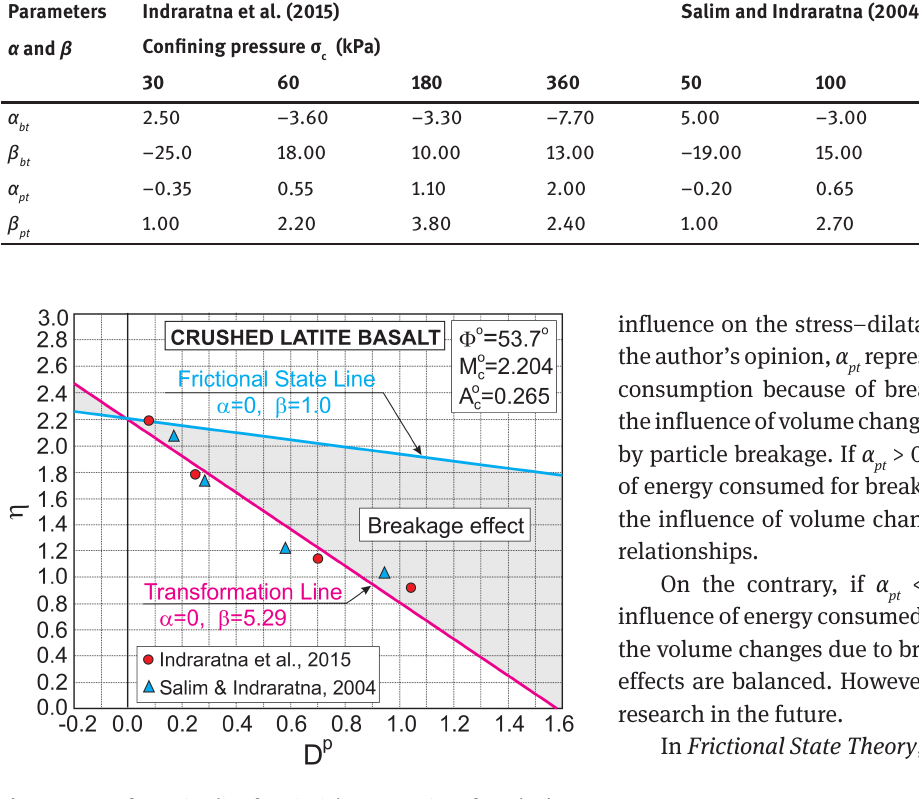
Figure 5: Transformation line for triaxial compression of crushed latite basalt.